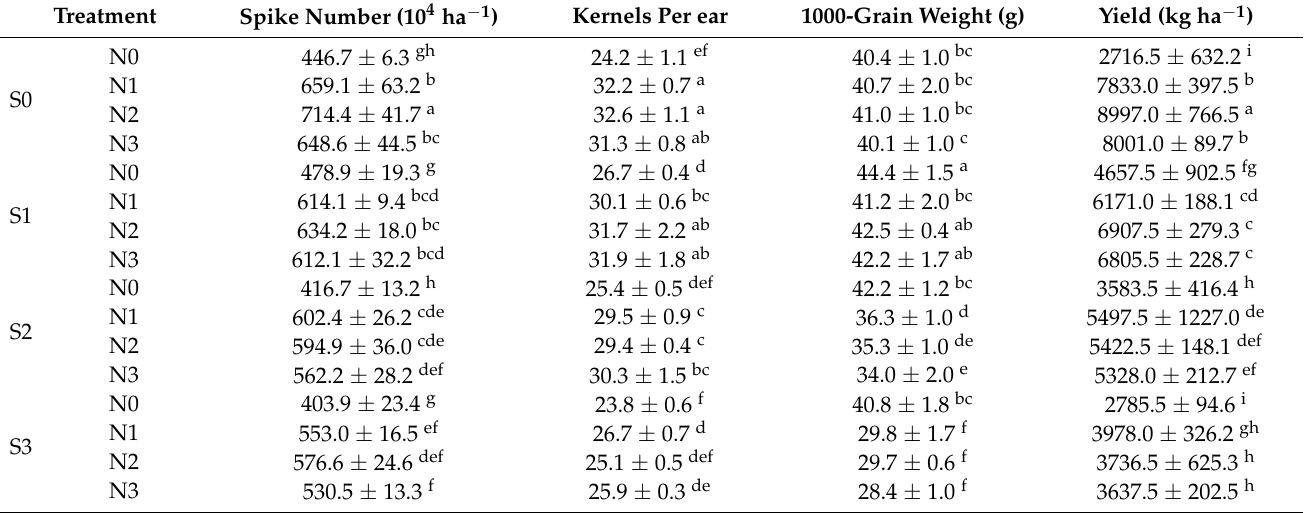
Table 4. Change of yield and yield components in the different